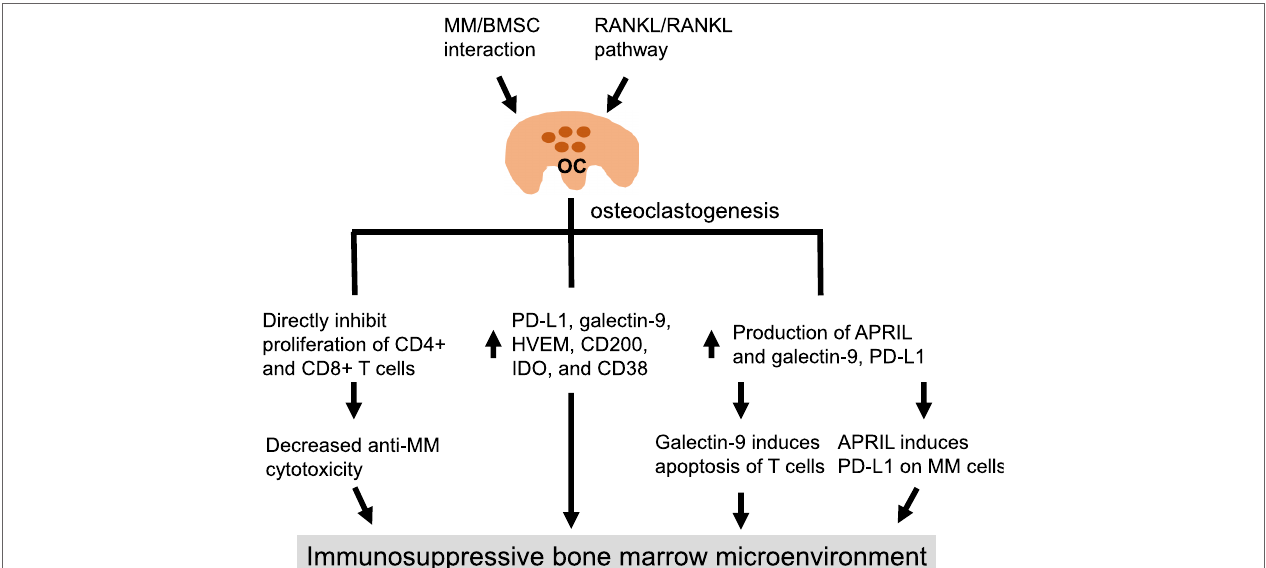
FigURe 1 | Osteoclasts create an immunosuppressive microenvironment in multiple myeloma (MM). In MM, the interaction of MM cells and bone marrow stromal cells induces production of various cytokines and growth factors, as well as activates RANK/receptor activator of nuclear factor- κ B (NF- κ B) ligand pathway, to promote the differentiation and expansion of OCs from CD14 + OC precursors. OCs can directly inhibit proliferation of activated CD4 + and CD8 + effector T cells, thereby reducing their numbers and leading to decreased MM cell lysis. The expression of multiple immune checkpoint molecules on OCs is increased during osteoclastogenesis. Furthermore, the secretion of galectin-9 and APRIL is significantly augmented during OC formation, resulting in apoptosis of T cells, i.e., mediated by galectin-9, and enhanced programmed cell death ligand 1 expression on MM cells, i.e., mediated by APRIL, IL-6. APRIL, a proliferation-inducing ligand; BMSC, bone marrow stromal cell; HVEM, herpesvirus entry mediator; IDO, indoleamine 2,